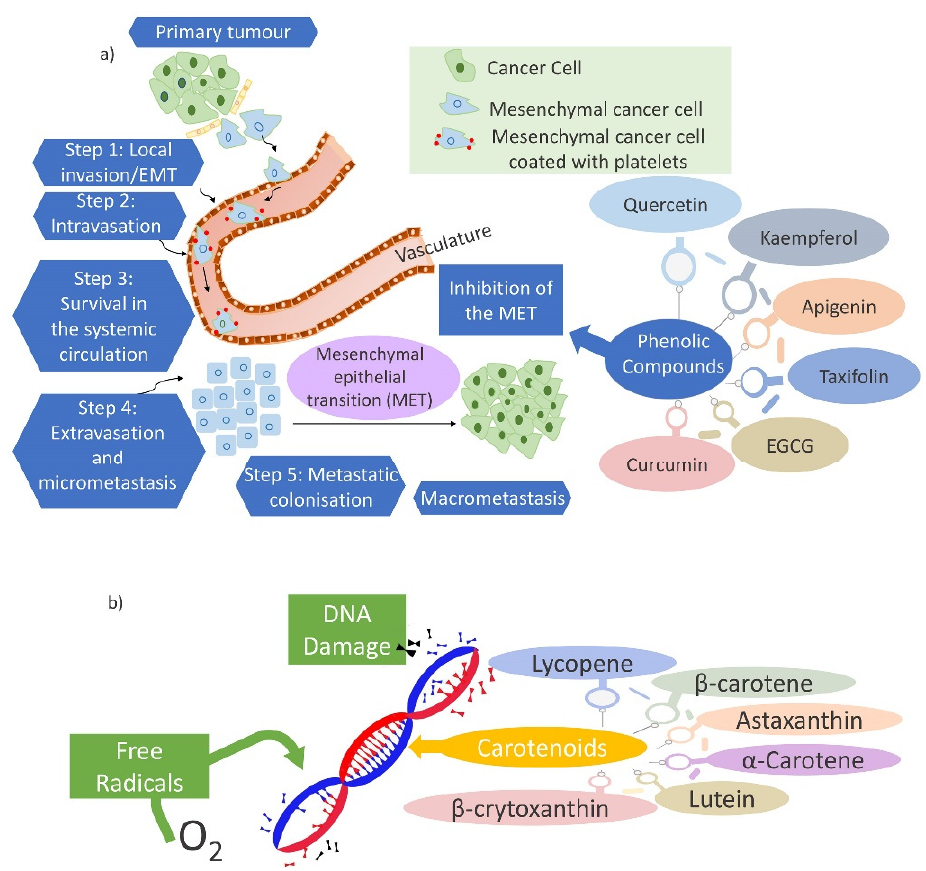
Figure 7. ( a ) The inhibition of the epithelial–mesenchymal transition (EMT) by phenolic